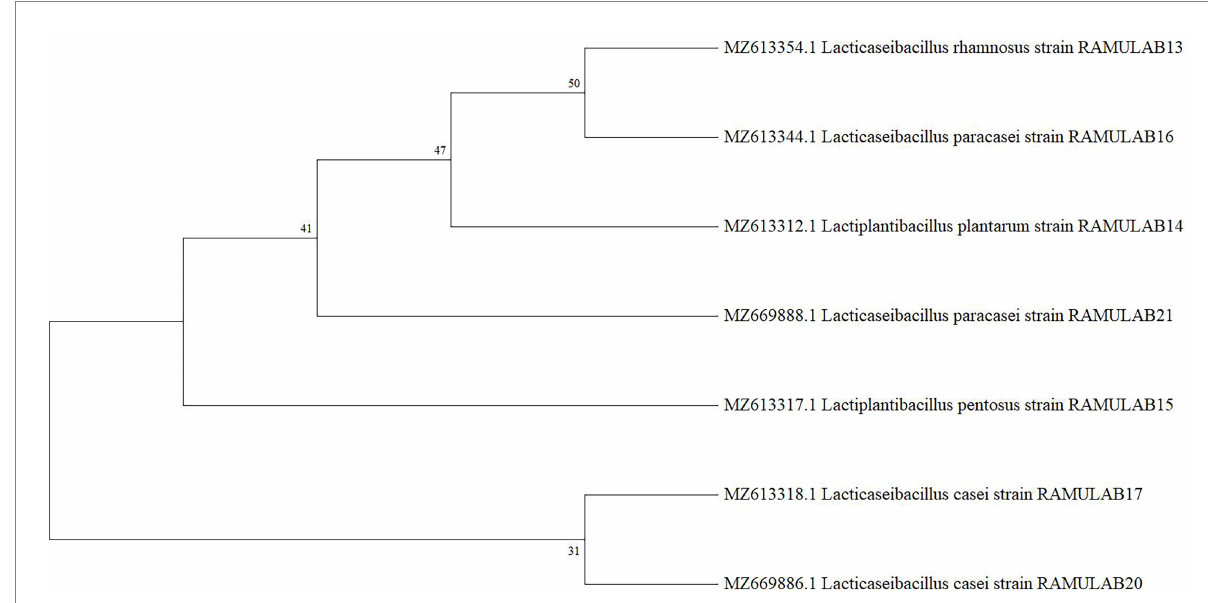
FIGURE 5 Analysis of the phylogenetic relationships among LAB isolates, based on 16S rRNA maximum likelihood bootstrap